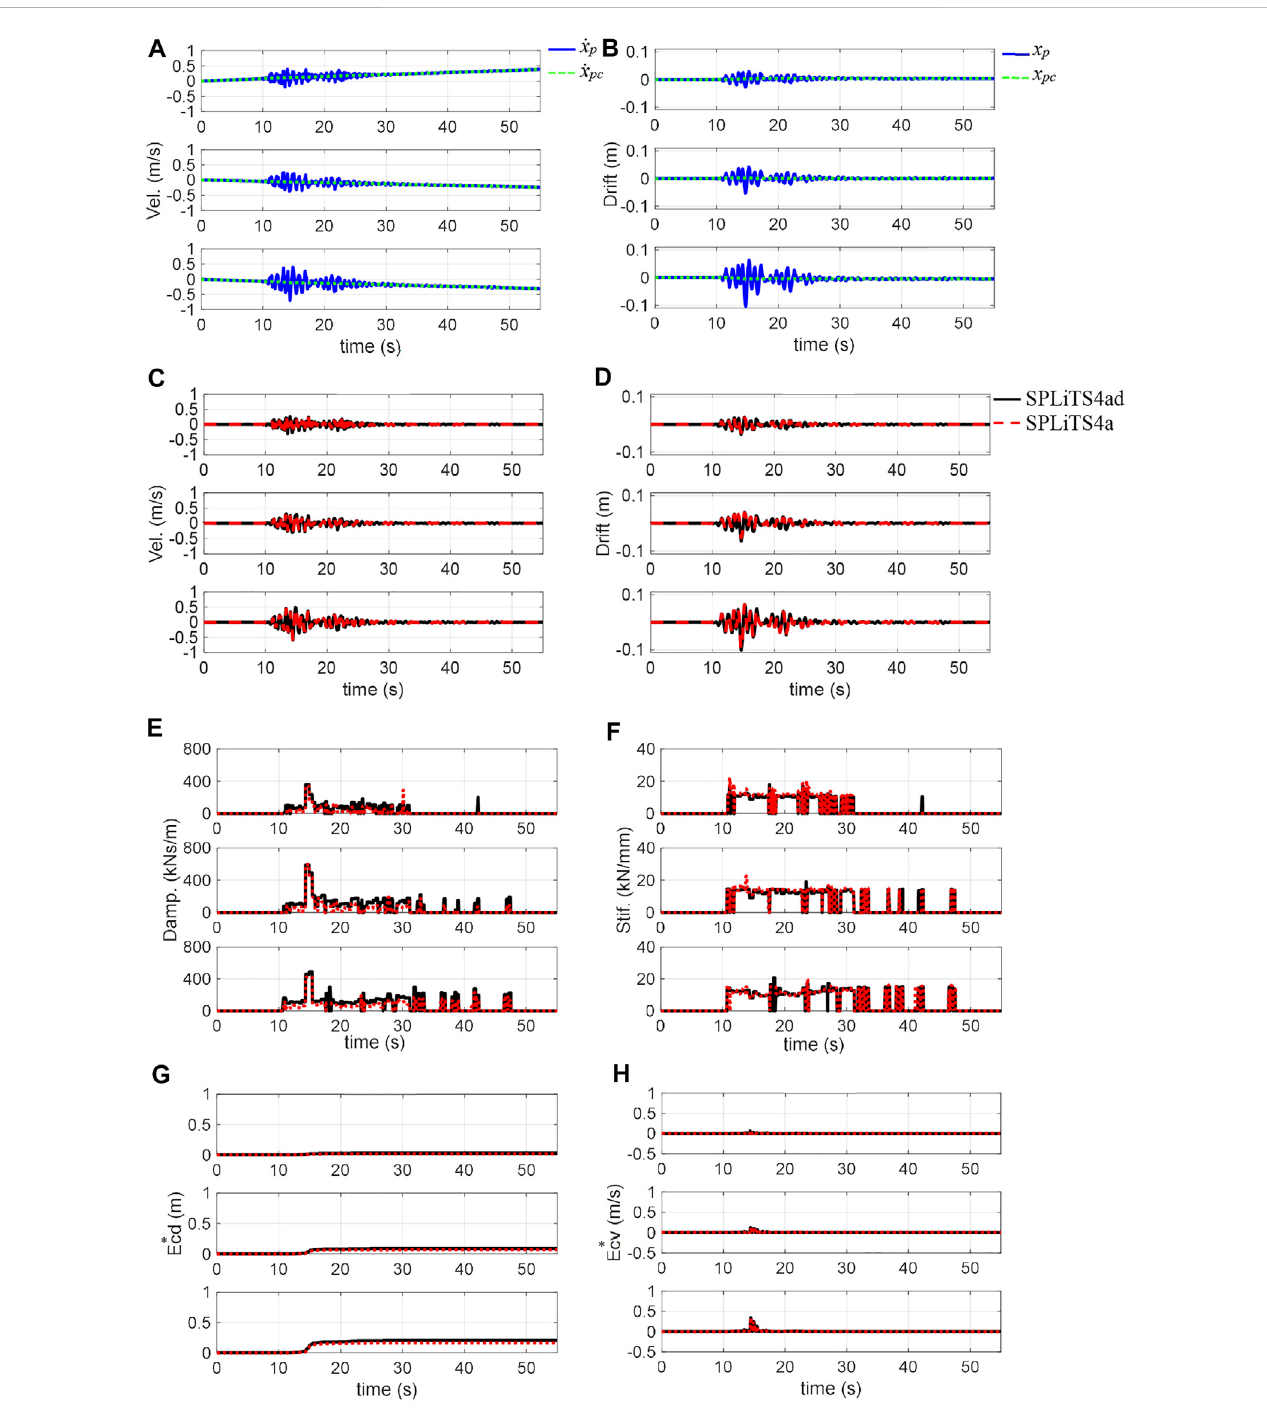
FIGURE 12 Structural responses of 60% Takatori and estimates by SPLiTS: (A) velocity obtained by integration, (B) displacement obtained by integration, (C) velocity with minimised central-point shift components, (D) displacement with minimised central-point shift components, (E) estimated damping, (F) estimated stiffness, (G) structural energy absorption E* cd , and (H) energy absorbing rate E* cv . N.B.: The top, middle and bottom in each fi gure corresponds to third, second, and fi rst storeys,